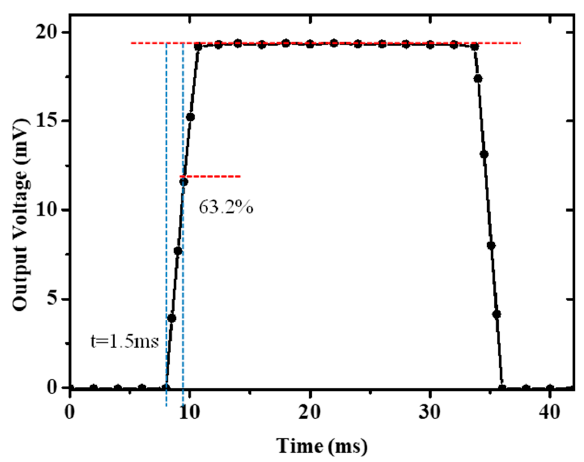
Figure 10. Dynamical response of the type B sensor to Pt heater with a heating power step input.